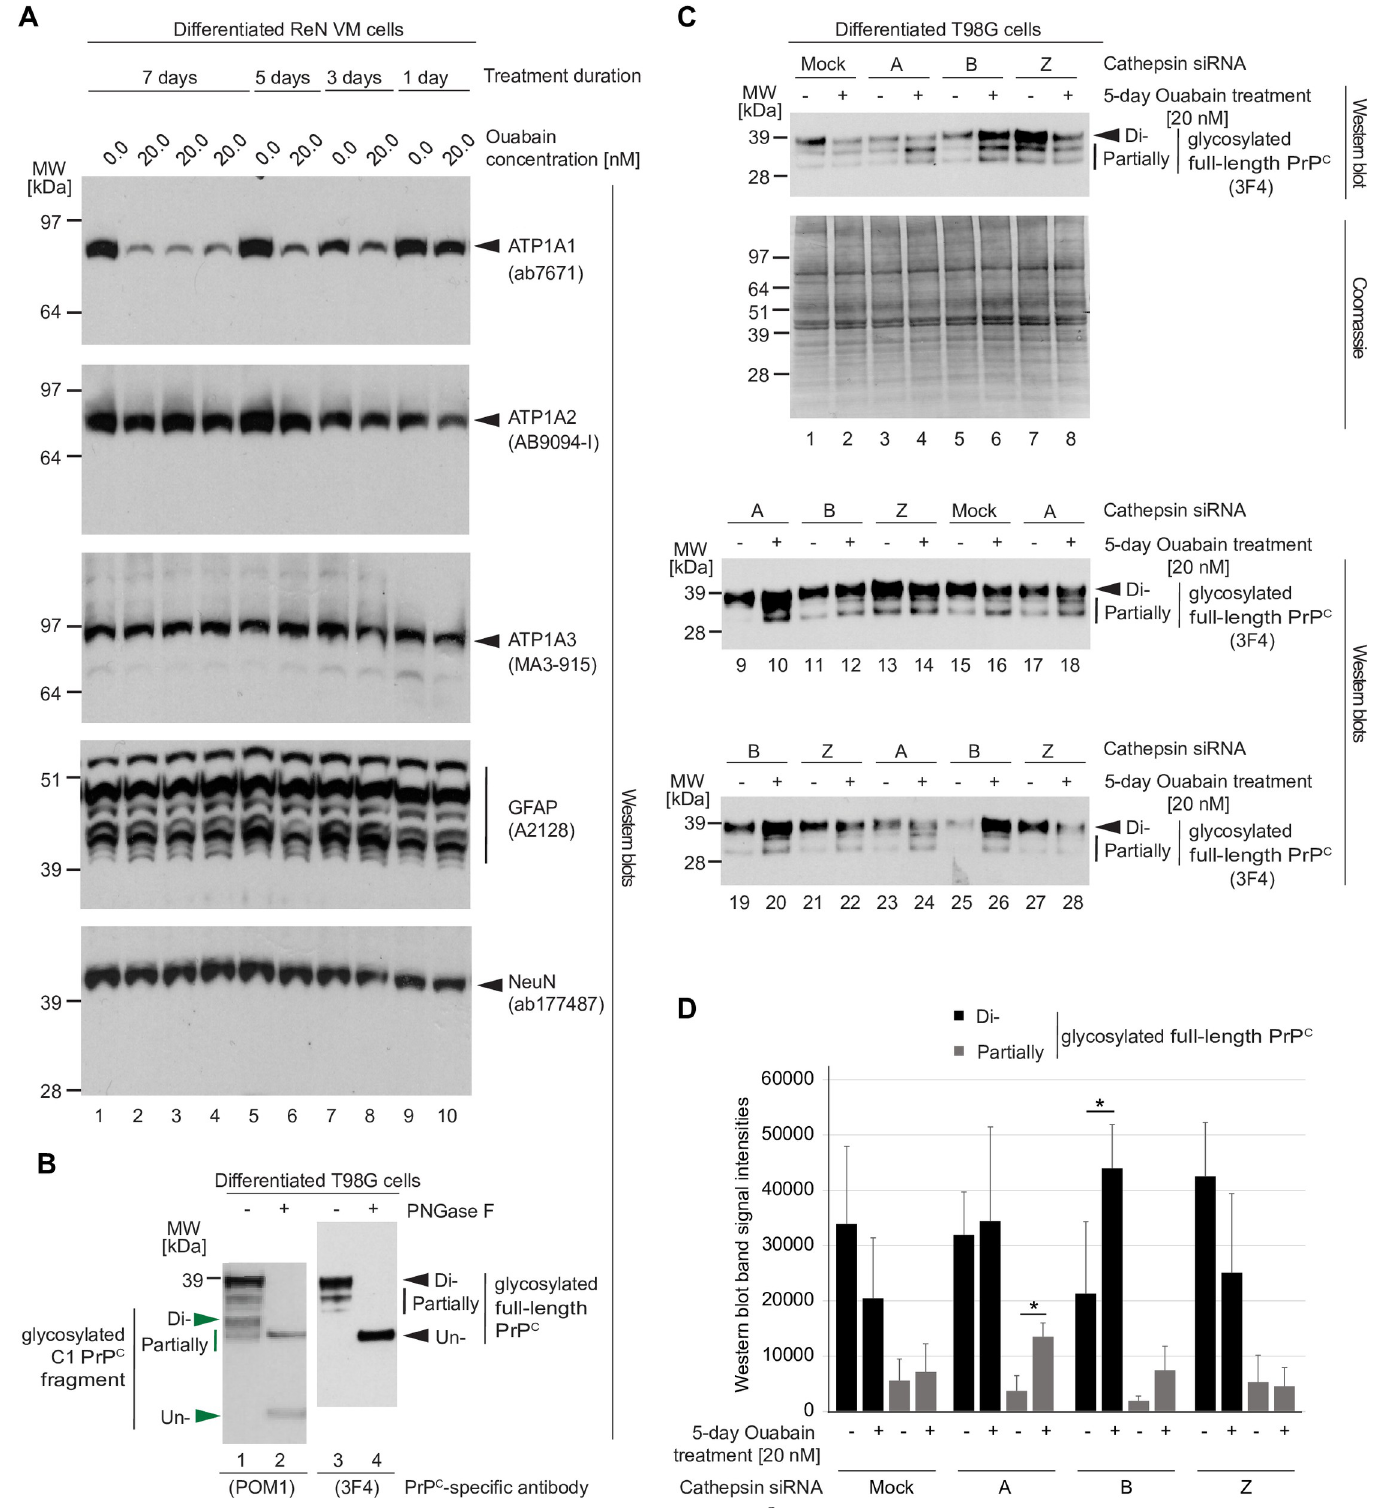
Fig 4. Cathepsin B is the main cathepsin involved in the ouabain-induced reduction in PrP C levels. (A) Treatment with 25 nM ouabain over 3 to 7 days is sufficient to induce a profound reduction in ATP1A1 protein levels in T98G cells. (B) PrP C in T98G cell extracts consists primarily of diglycosylated full-length PrP C , with partially N- glycosylated and endoproteolytically cleaved PrP C representing a minor sub pool. (C) Western blot and Coomassie SDS-PAGE analyses of cell extracts from T98G cells